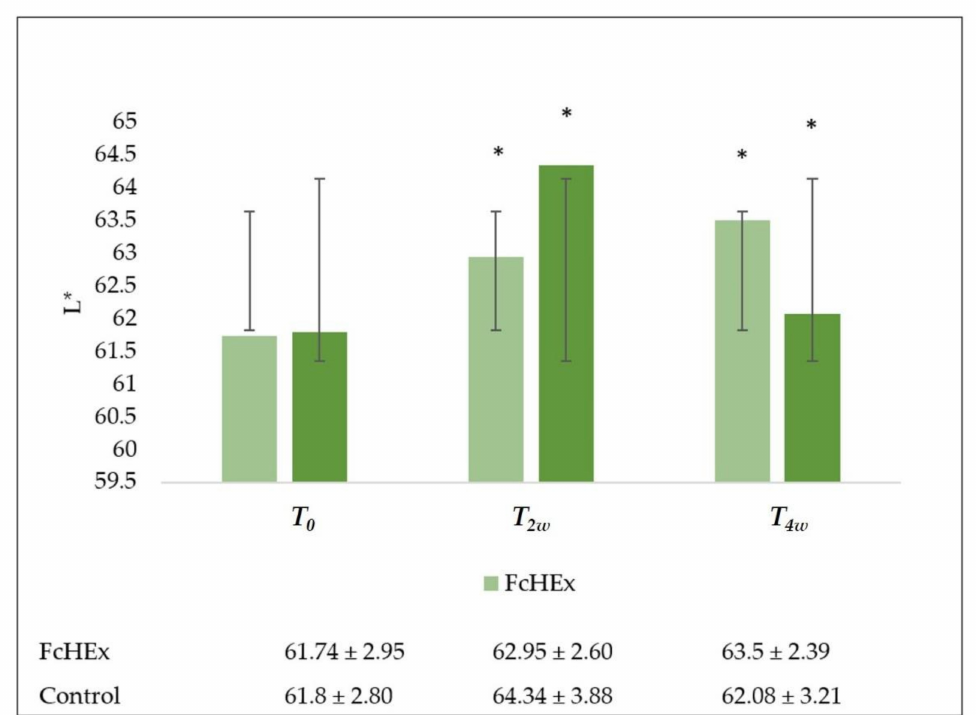
Figure 12. Skin lightness evaluation. Skin lightness trend values at time T 0 (before the application), T 2w (after two weeks— acute stress), T 4w (after four weeks—recovery effect). All the measures T 2W vs. T 0 and T 4w vs. T 0 for the FcHEx and the control were statistically significant. The asterisks indicate statistically significant values (* p -value was between 0.01 and 0.05).